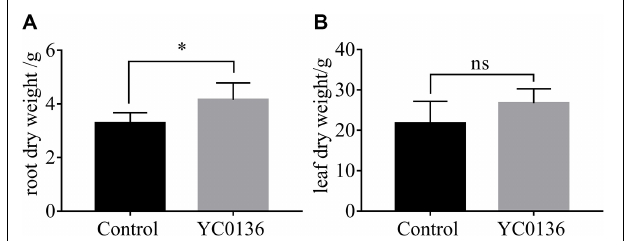
FIGURE 3 | Effects of YC0136 on tobacco dry biomass at 60 days after inoculation. Plants were collected at 60 days after inoculation, dried at 105 ◦ C for 30 min, and then dried at 80 ◦ C to maintain constant weight. The data were analyzed by t -tests. The error bars were standard deviation of the group. (A) Statistical results for root dry weight at 60 days after inoculation. (B) Statistical results for leaf dry weight at 60 days after inoculation. Three replicates were used for statistical analysis. Error bars indicate the SD from the mean. “*” Indicates a significant difference at the p < 0.05 level in t -tests. “ns” Means that there is no significant difference at the p < 0.05